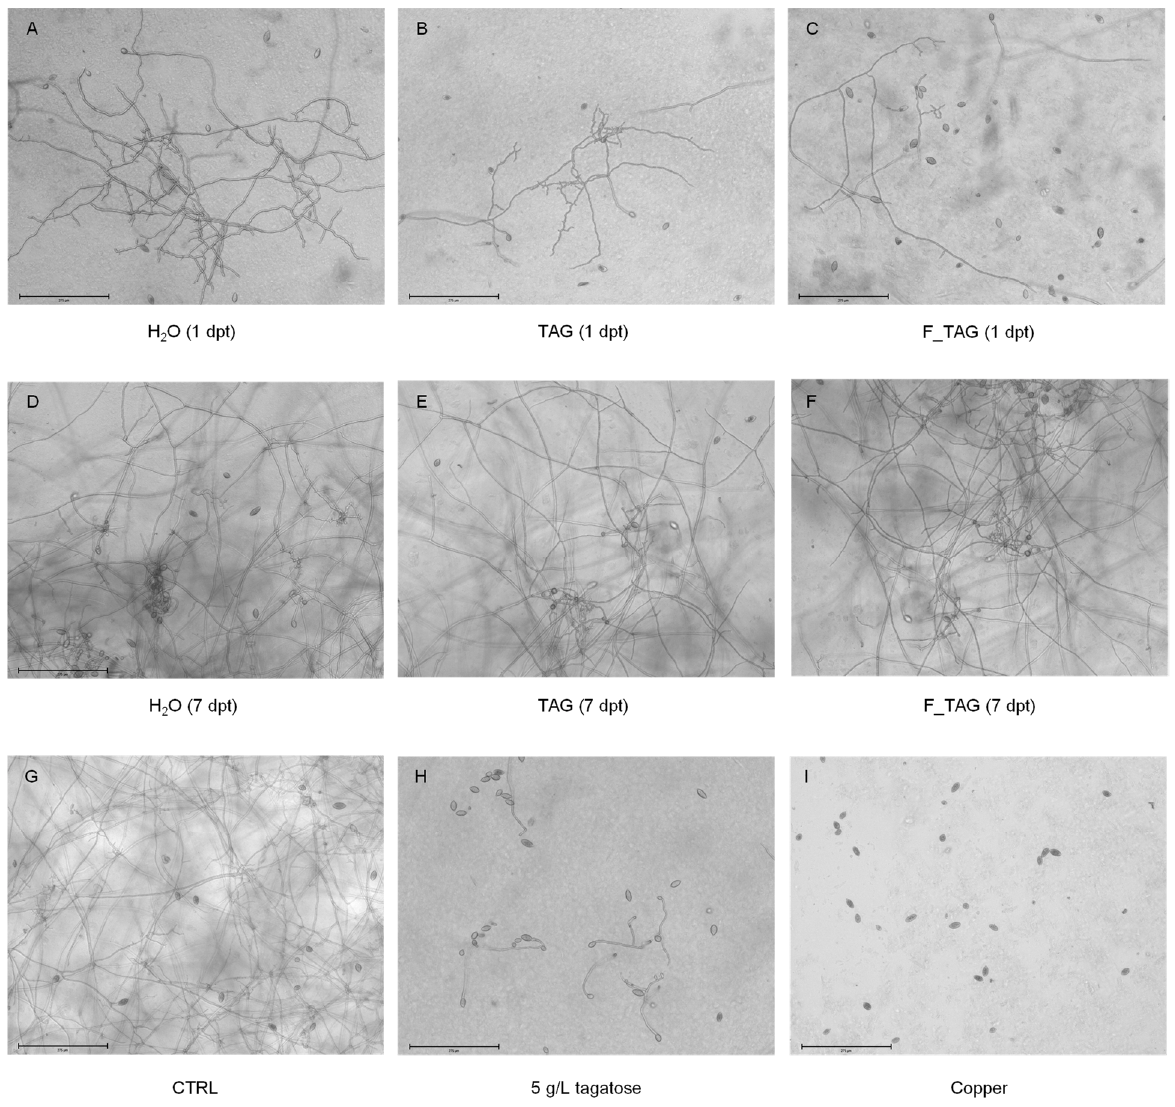
Figure 3. Pictures of Phytophthora infestans growth inhibition by leaf washing suspensions. Phytophthora infestans sporangia were incubated in the presence of leaf washing suspensions collected at one and seven days post-treatment (dpt) from plants treated with water (H 2 O; ( A , D )), 5 g/L pure tagatose (TAG; ( B , E )) or a formulated product that contained 5 g/L tagatose (F_TAG; ( C , F )). Sporangia were incubated in water (CTRL; G ), tagatose (5 g/L, H ), and copper hydroxide (10 g/L; I ) as controls. Representative pictures were taken at 72 h of incubation. Bars correspond to 275 µm.